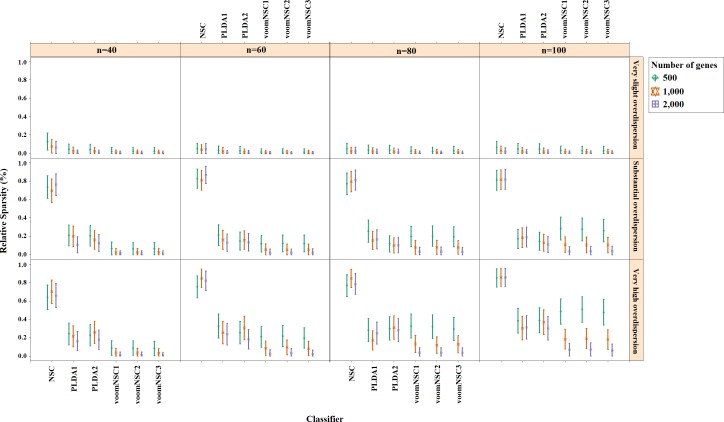
Sparsities of classifiers for the simulation scenario K = 2, egk = 5%, σ = 0.1.